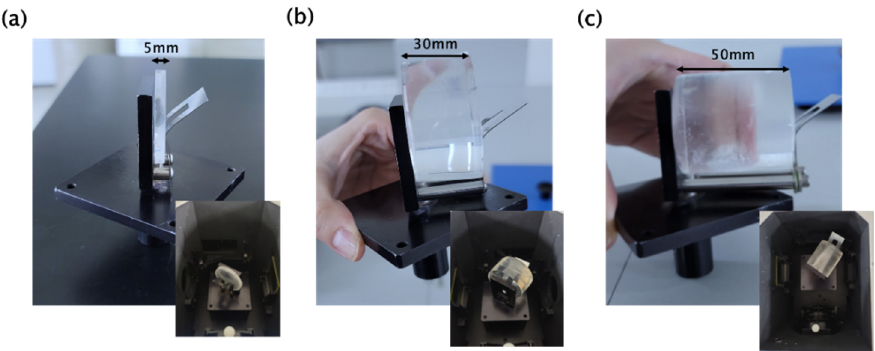
Figure 5. Holder with different spacer bars for photoluminescence analysis of plastic scintillator fabricated. ( a ) 5 mm thickness; ( b ) 30 mm thickness; ( c ) 50 mm thickness.